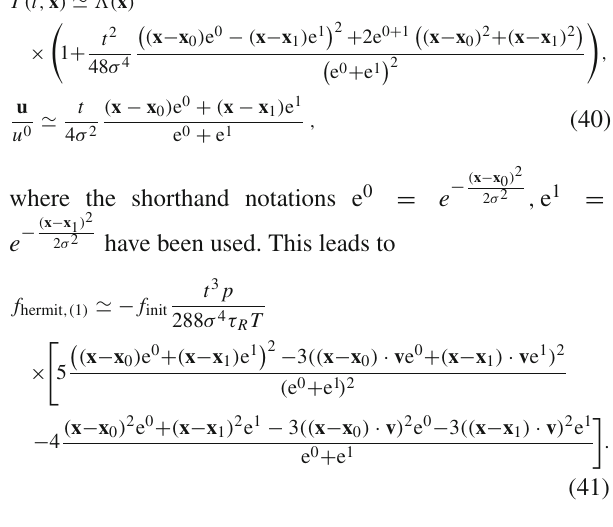
at x = ∓ σ . Show are numerical results for first order eremitic expan- sion and early-time approximations thereof for τ R T = 1, as well as numerical results for 0 th order fluid